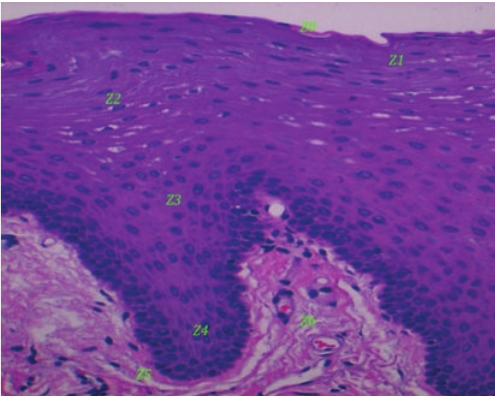
Figure 1: Histology image of healthy oral lower lip mucosa with ref- erence marks (Z) showing where standardized depth reflectance confocal microscopy evaluation was peformed.